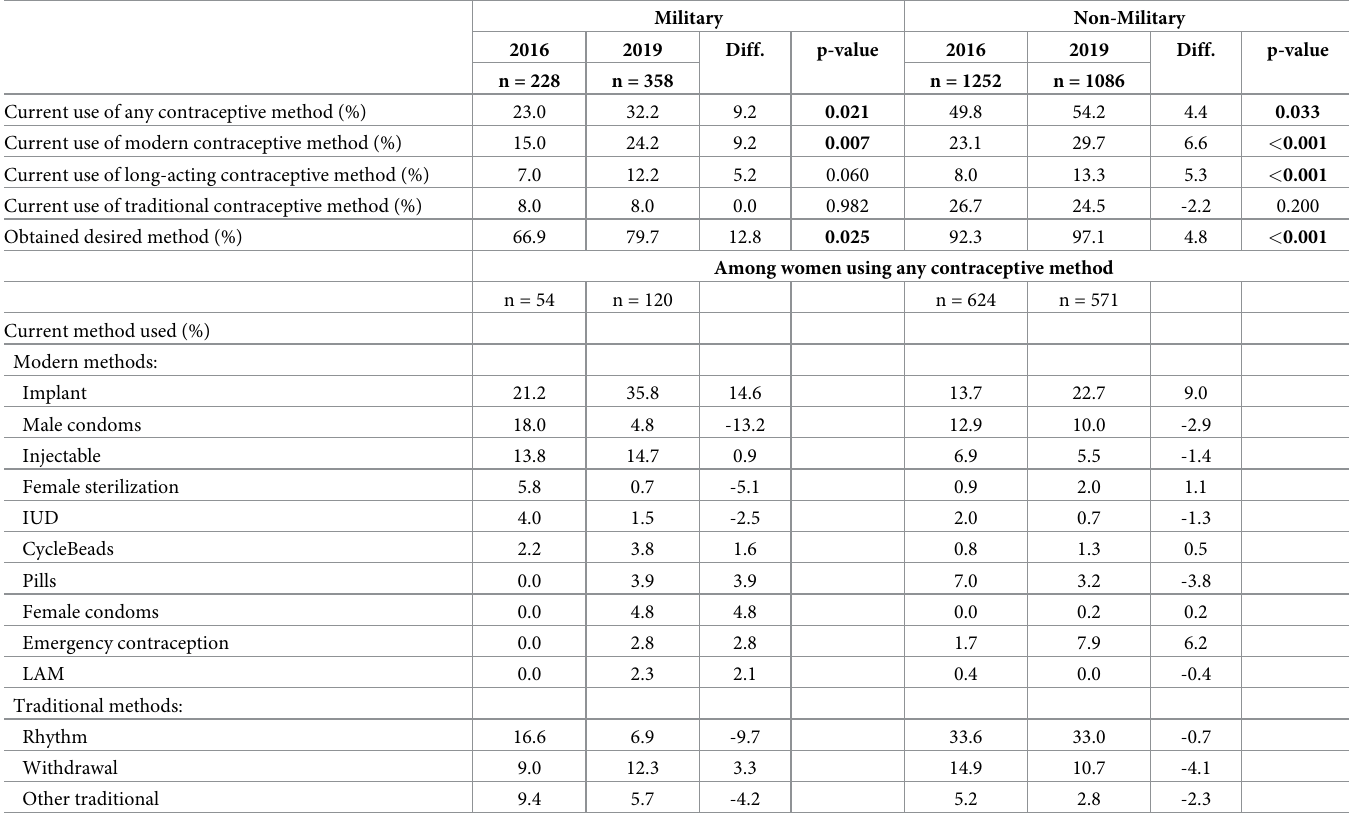
Table 3. Contraceptive use and method mix among women married or in union in Kinshasa, by type of population and year of survey.